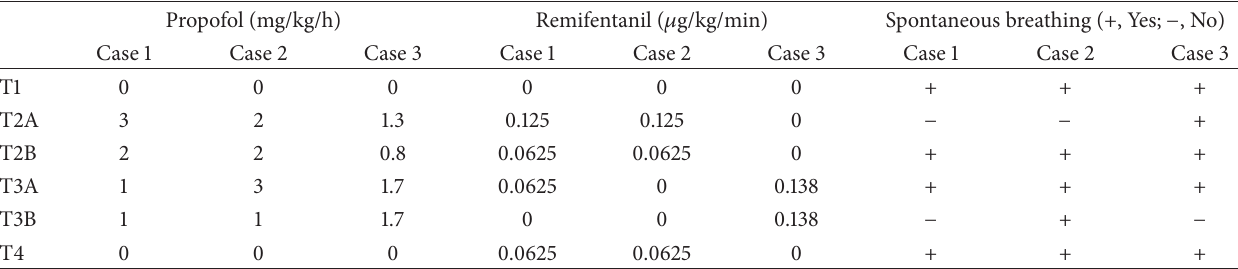
Table 1: Infusion rates of propofol (10mg/mL) and remifentanil (40 𝜇 g/mL) used in sedation maintenance and spontaneous breathing during the PELD